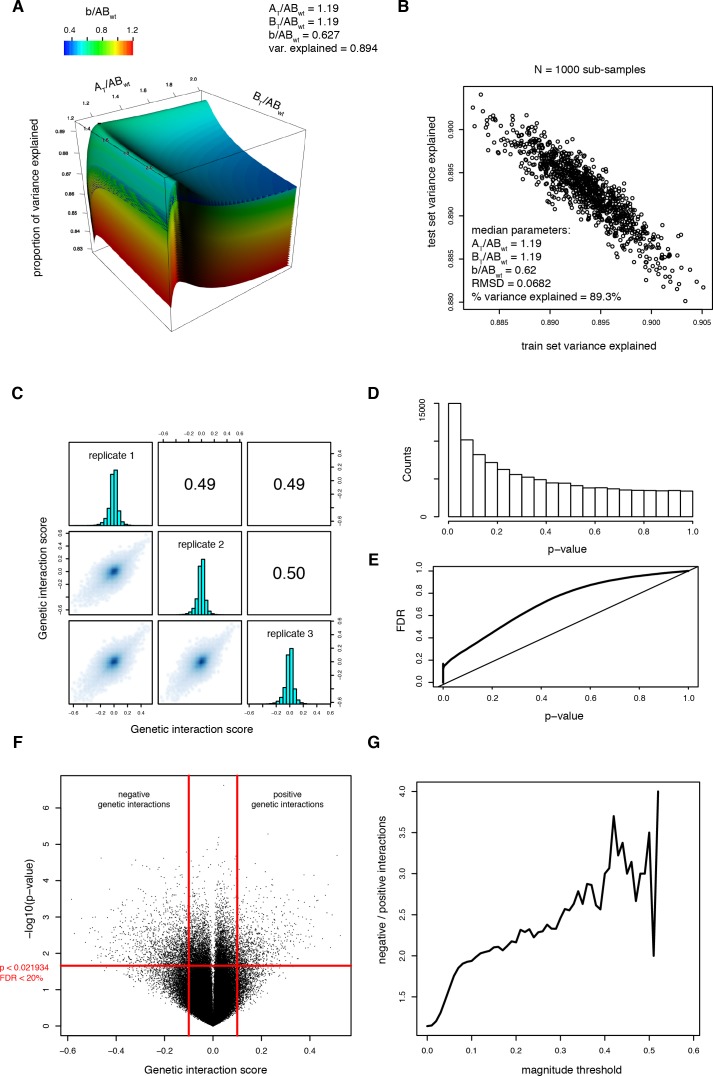
Fitting the thermodynamic model on the trans library data.(A) Parameter search. Proportion of variance explained as a function of the three parameters of the thermodynamic model. The third parameter (b/ABWT) is represented as surfaces of different colors. The black dot represents the highest percentage of variance explained. (B) Result of Monte-Carlo cross-validation to ensure that the model is not over-fitted. The procedure is described in the Materials and methods section. The median of the free parameters over 1000 sub-samplings is identical, confirming that the model is not over-fitted. (C) Correlations between genetic interaction scores from the three biological replicates calculated from the thermodynamic model. (D) Distribution of the p-values from the one-sample t-tests performed on the genetic interaction scores (i.e. residuals from the thermodynamic model) from three replicates of each double mutant. (E) FDR calculated by permutation of genetic interaction scores (see method) as a function of the p-value threshold. (F) Volcano plot of the p-values of each double mutant as a function of the corresponding average genetic interaction scores. Vertical red lines represent the magnitude threshold used to define strong genetic interactions. The horizontal red line represents the p-value threshold that corresponds to a FDR of 0.2. (G) Ratio of significantly negative to positive genetic interactions at different magnitude thresholds showing that negative genetic interactions are more prevalent than positive genetic interactions.